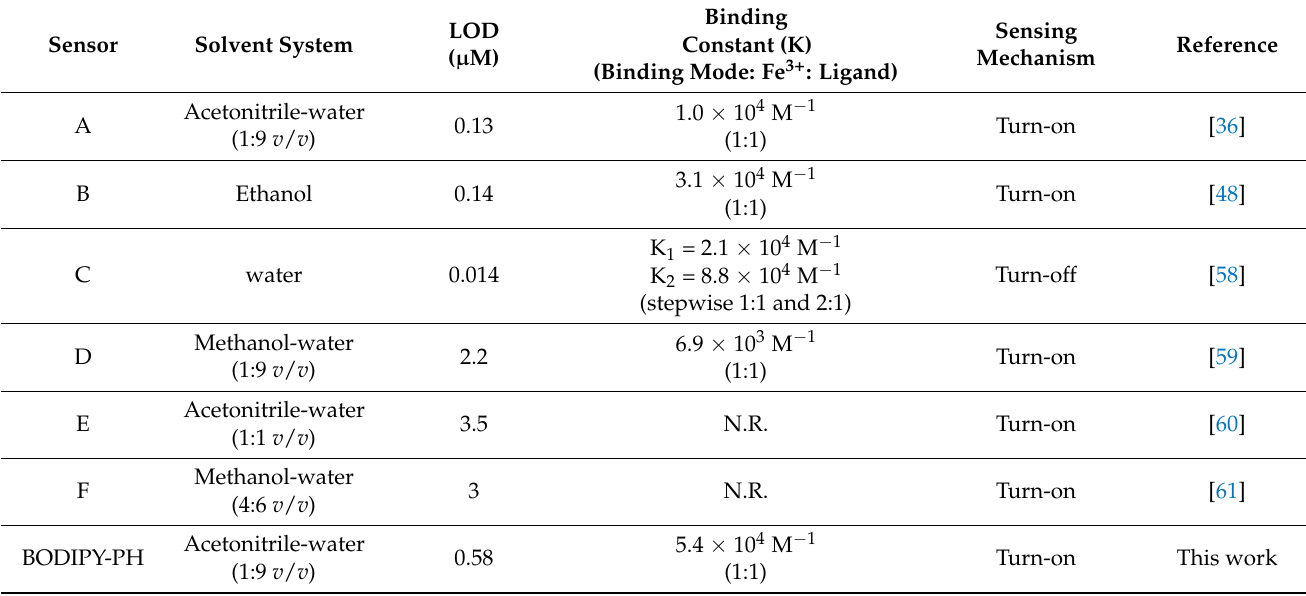
Table 1. Comparison of BODIPY-PH with other reported BODIPY- and rhodamine-based sensors for ferric ion detection.